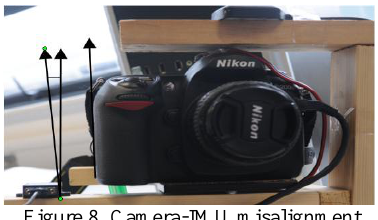
Figure 8. Camera-IMU misalignment